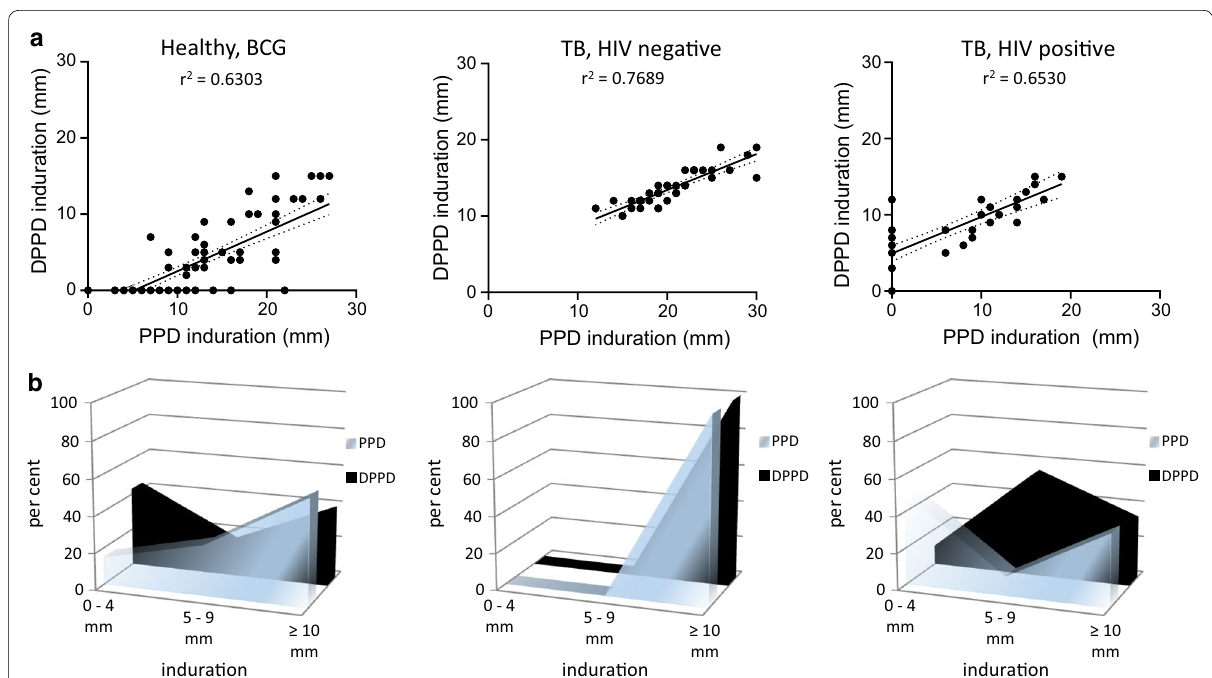
Fig. 1 Skin testing with recombinant proteins. Healthy, BCG immunized individuals (n (n 38) for HIV infection, were intradermally inoculated with 5 TU of Tubersol PPD Tuberculin or the bioequivalent 1 µg of DPPD. Induration was = measured 24 h later. Results were determined to be positive when, consistent with CDC guidelines, induration > 10 mm in HIV negative individuals and > 5 mm in HIV positive individuals. In A, each dot represents an individual data point, while the solid line represents the correlation of results and the black dotted lines represent the 95% confidence intervals. The r 2 value is indicated in the text insert. In B, per cent of each group falling within the indicated induration range is